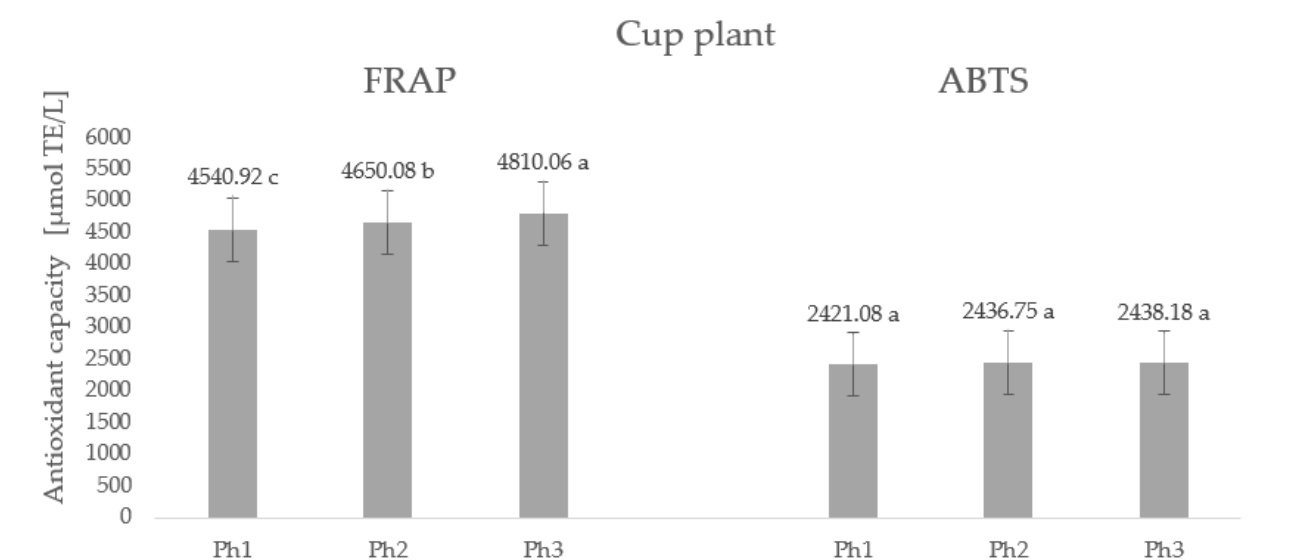
Figure 4. Antioxidant capacity (µmol TE/L) of fresh leaves of cup plant. Results are expressed as mean ± standard deviation. Different letters indicate significant differences between mean values.